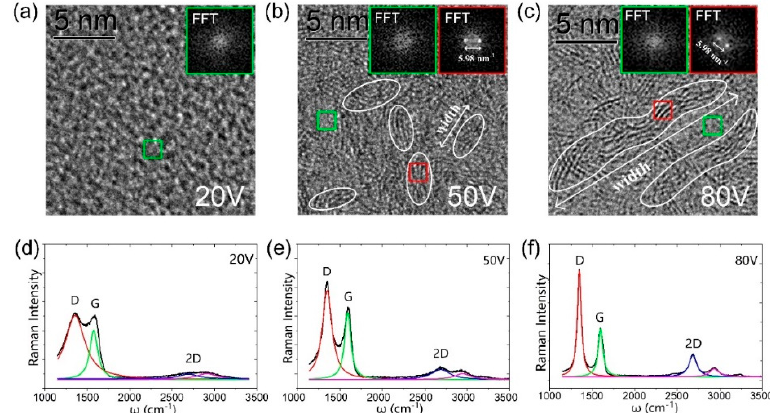
Figure 2. High-resolution TEM plan-view images of GNEC films deposited at a V dep of ( a ) 20 V, ( b ) 50 V, and ( c ) 80 V. Insets are the fast Fourier transform (FFT) images of the selected region (green and red squares). As the V dep increases, the GN boundary width increases. Raman spectra of GNEC films with a V dep of ( d ) 20 V, ( e ) 50 V, and ( f ) 80 V. As the V dep increases, D, G, and 2D peaks are all sharpened.